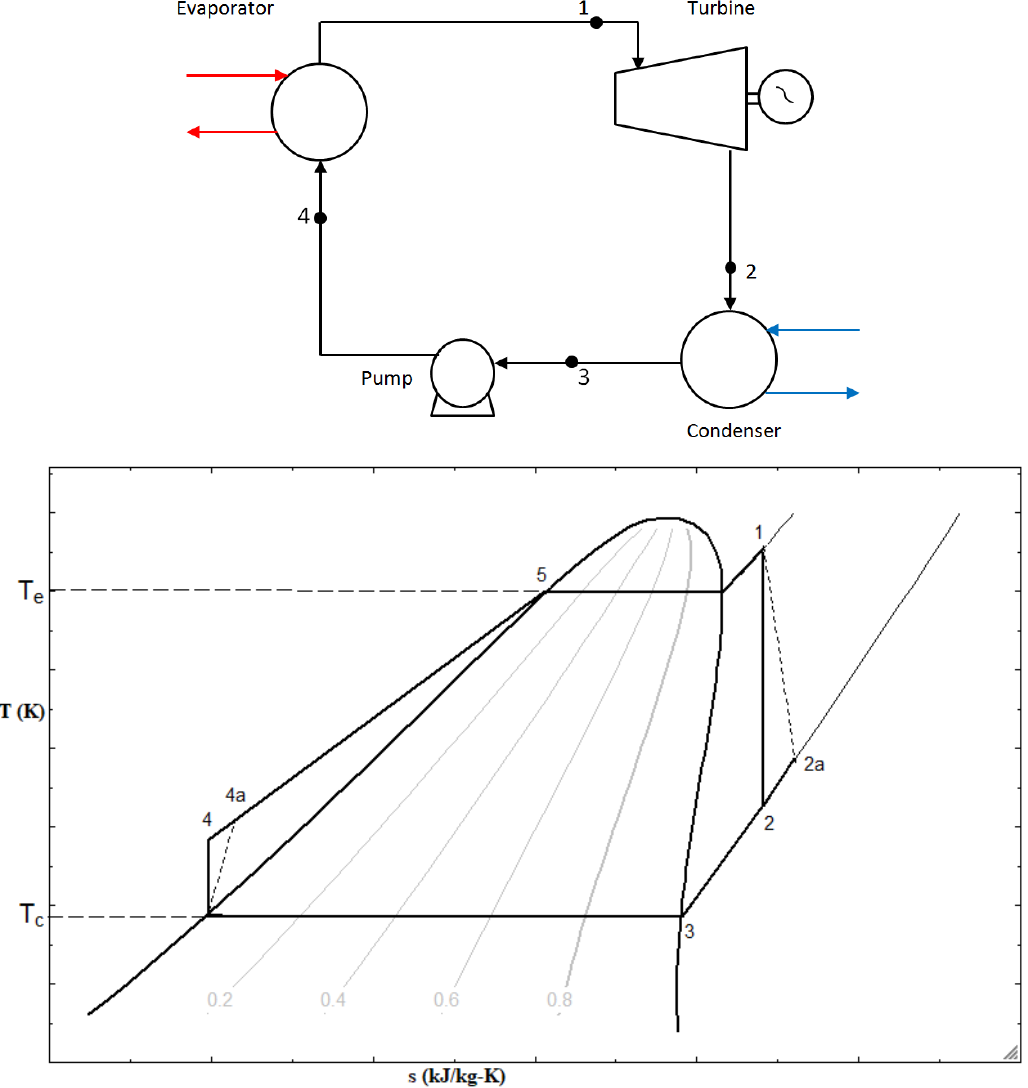
Figure 1. Schematic diagram of the cycle and T-S thermodynamic diagram of the basic organic Rankine cycle (BORC) system.